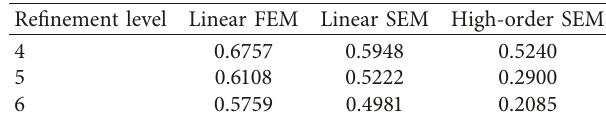
Table 8: L 2 norm of the dynamic condensation distribution at 30ms.